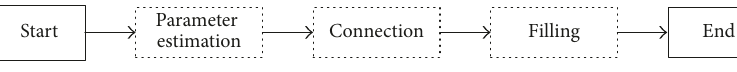
Figure 2: The flowchart of missing value